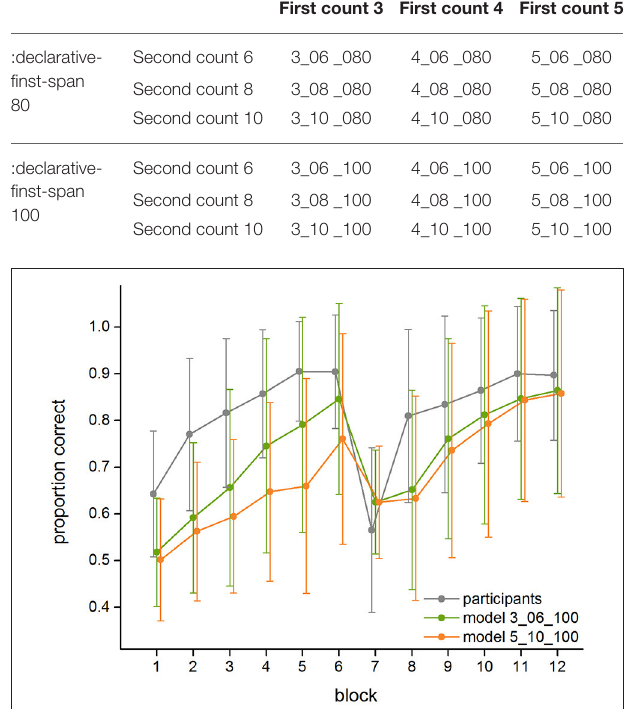
FIGURE 4 | Average performance and standard deviations of the human participants, the best fitting model (3_06_100), and the worst fitting model (5_10_100) in the 12 blocks of the